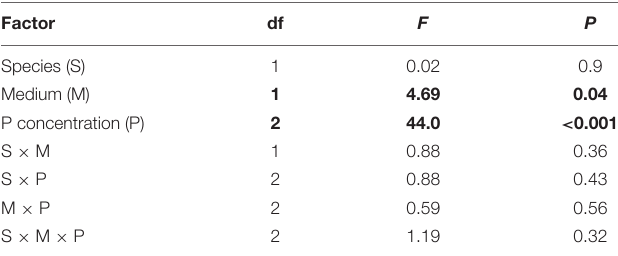
TABLE 1 | Results of three-way ANOVA testing the effects of species ( C. elongata vs. C. silvae-gabretae ), media (inorganic vs. organic), and three P concentrations on growth